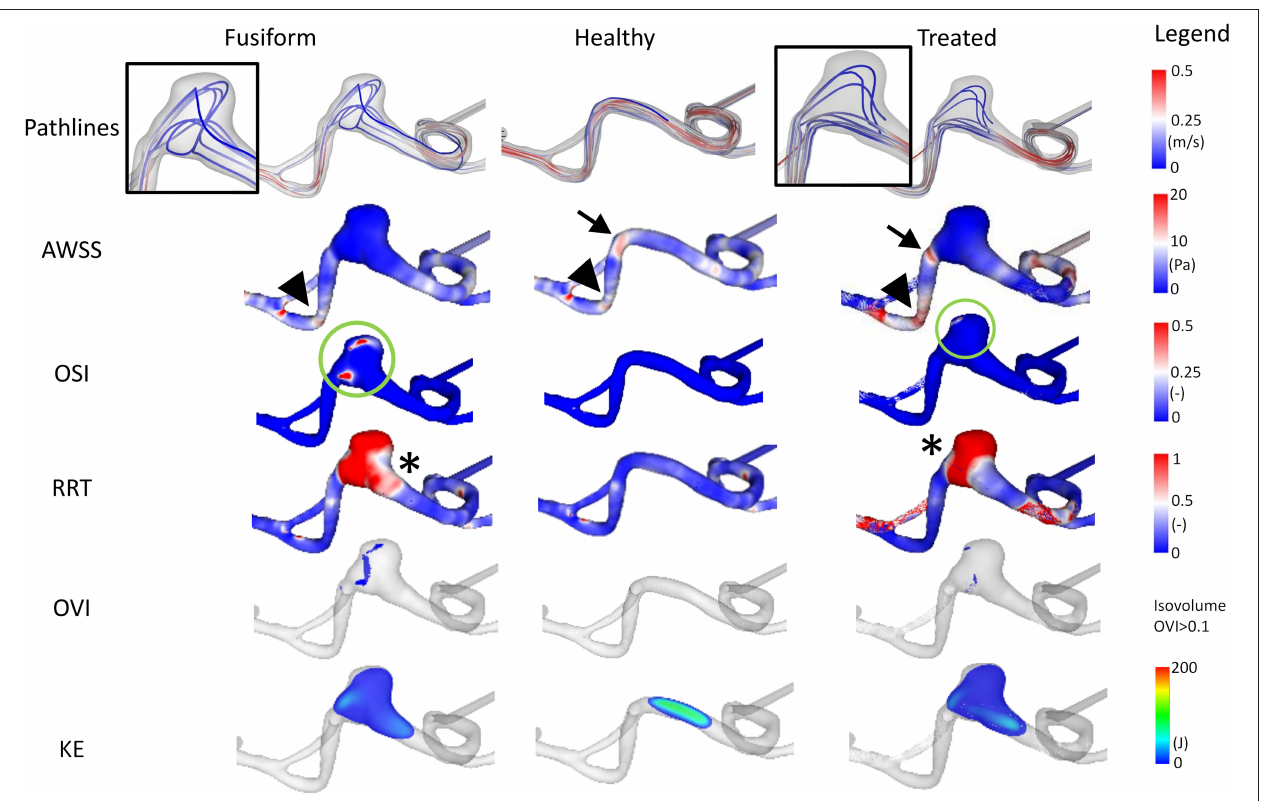
FIGURE 4 | Illustration of the hemodynamic results for Case 2. Fusiform (left) denotes the 3D model of the FIA; Healthy (center) the manually-created healthy counterpart; Treated (right) the virtually stented model. The following flow- and shear-related parameters are presented from top to bottom: Pathline visualization, AWSS , OSI , RRT , OVI , KE